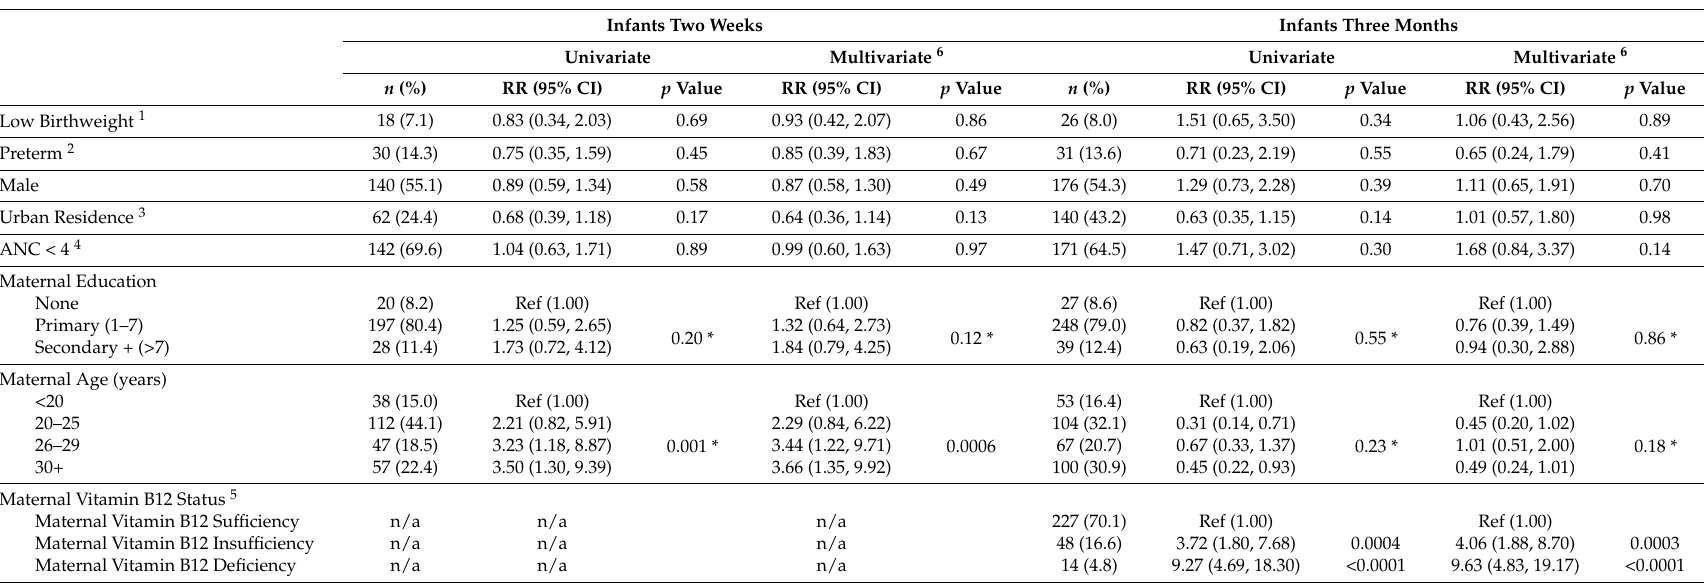
Table 5. Predictors for vitamin B12 deficiency for